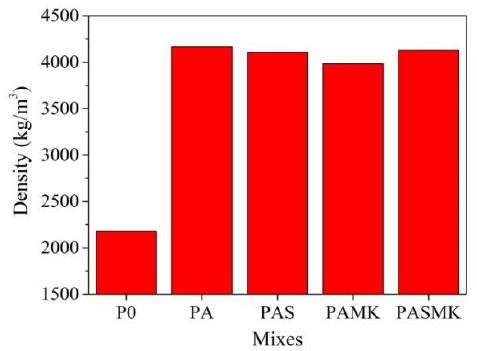
Figure 8. The density of P0 – PASMK